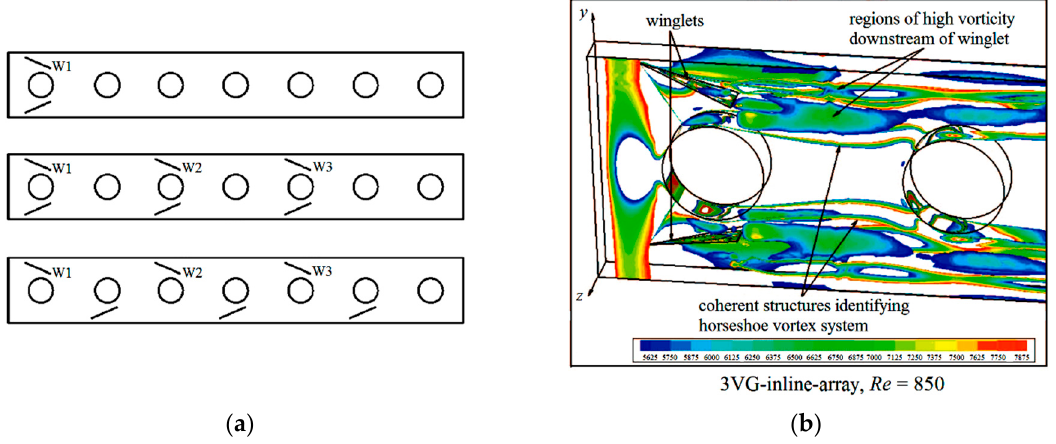
Figure 9. VGs with different winglet configurations [77]. ( a ) Configurations of the winglet pairs. ( b ) 3D iso-vorticity surfaces occurring at the junction of fin and tube.